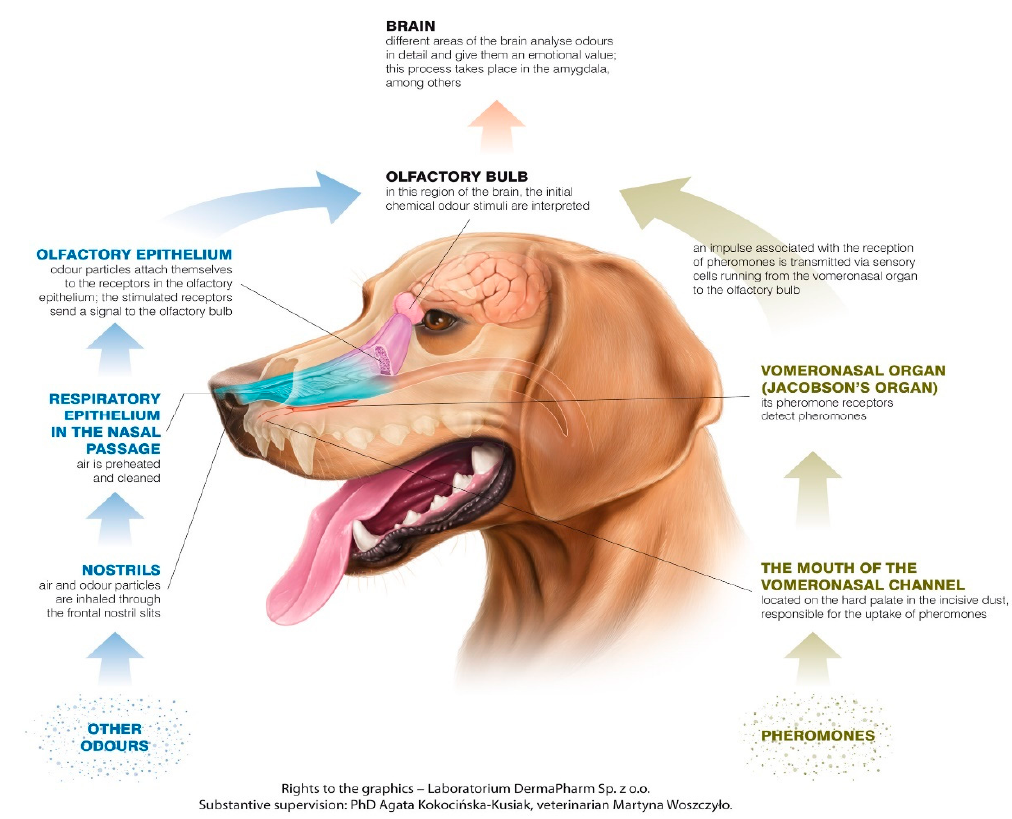
Figure 1. This schematic shows the traditional structure of the chemical substances detection system. Currently, the distinction between the so-called nose and the VNO in terms of the detection of odors and pheromones is not so obvious, and researchers tend to believe that both the “nose” receives pheromone signals and the VNO receives stimuli, with low-volatility odorant compounds suspended in the liquid phase.